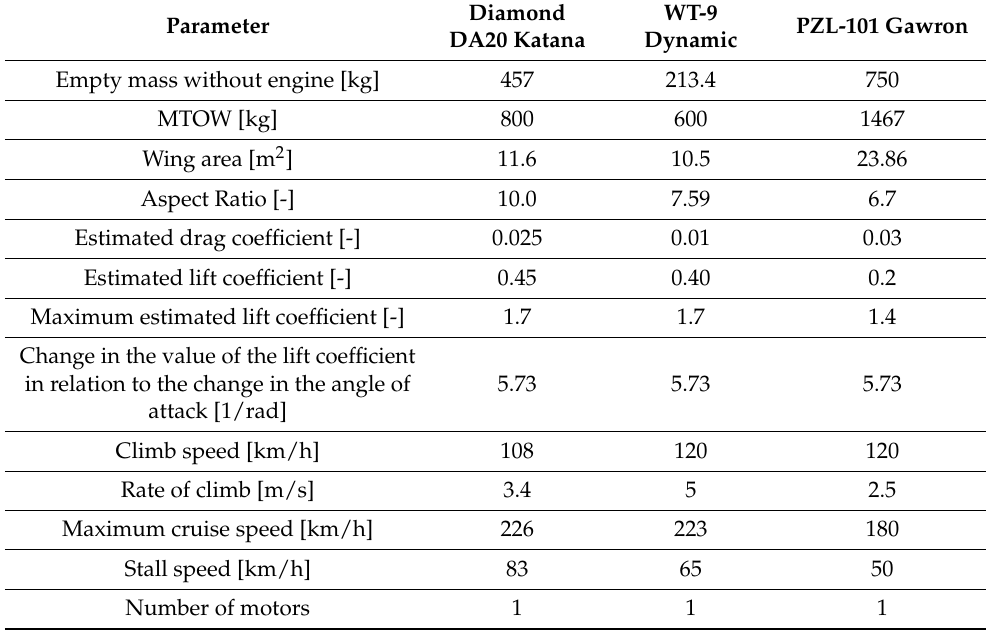
Table 2. Aircraft parameters [39–41].